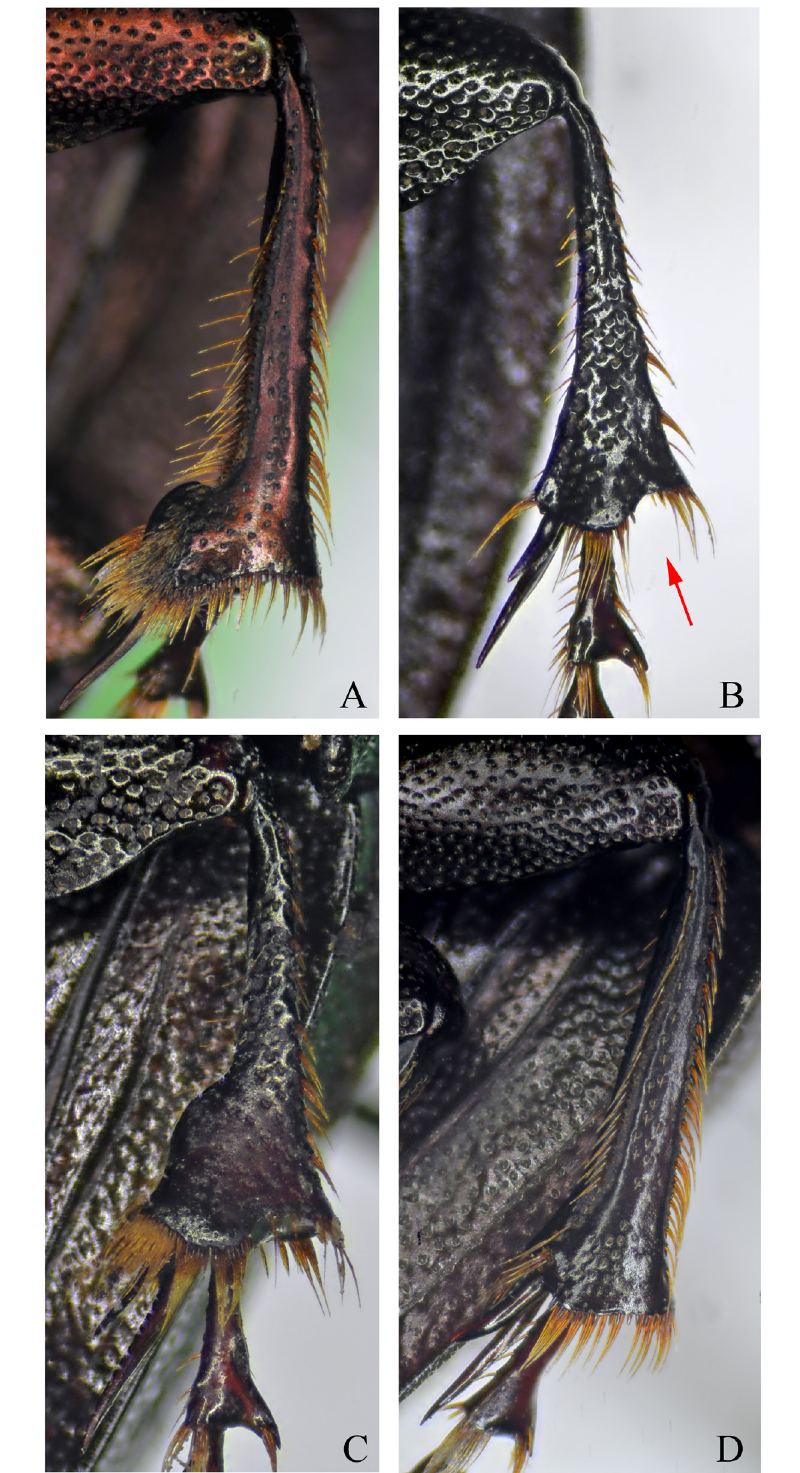
Fig. 18. Mesotibiae. A‒B . Streblopus opatroides van Lansberge, 1874. A . ♂. B . ♀. C‒D . S. punctatus (Balthasar, 1938). C . ♂. D . ♀. Observe that females of S. opatroides differ from those of S. punctatus by having a deep emargination at the apical edge of the mesotibiae (red arrow shows